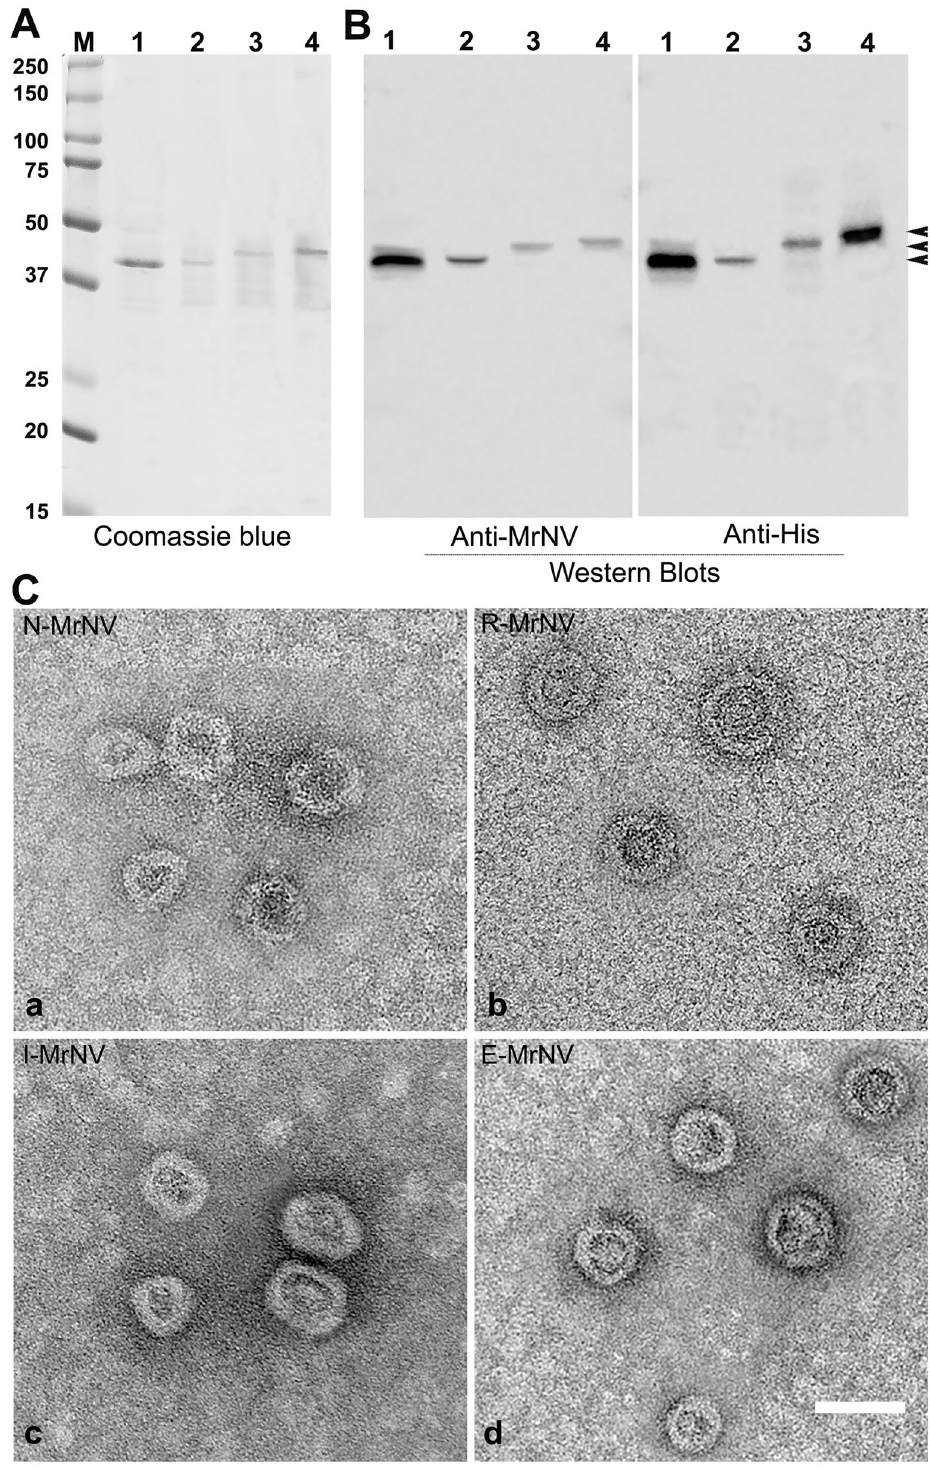
Figure 2. Protein profiles of chimeric GE11- MrNV-VLPs from SDS-PAGE and Coomassie blue staining ( A ) and their verification with Western blotting using anti-MrNV antibody or anti-His antibody ( B ). Lanes 1–4 represent N-MrNV, R-MrNV, I-MrNV, and E-MrNV, respectively. Electron micrographs of chimeric MrNV- VLP structures demonstrated by negative TEM staining are shown in panel ( C ). Bar = 50